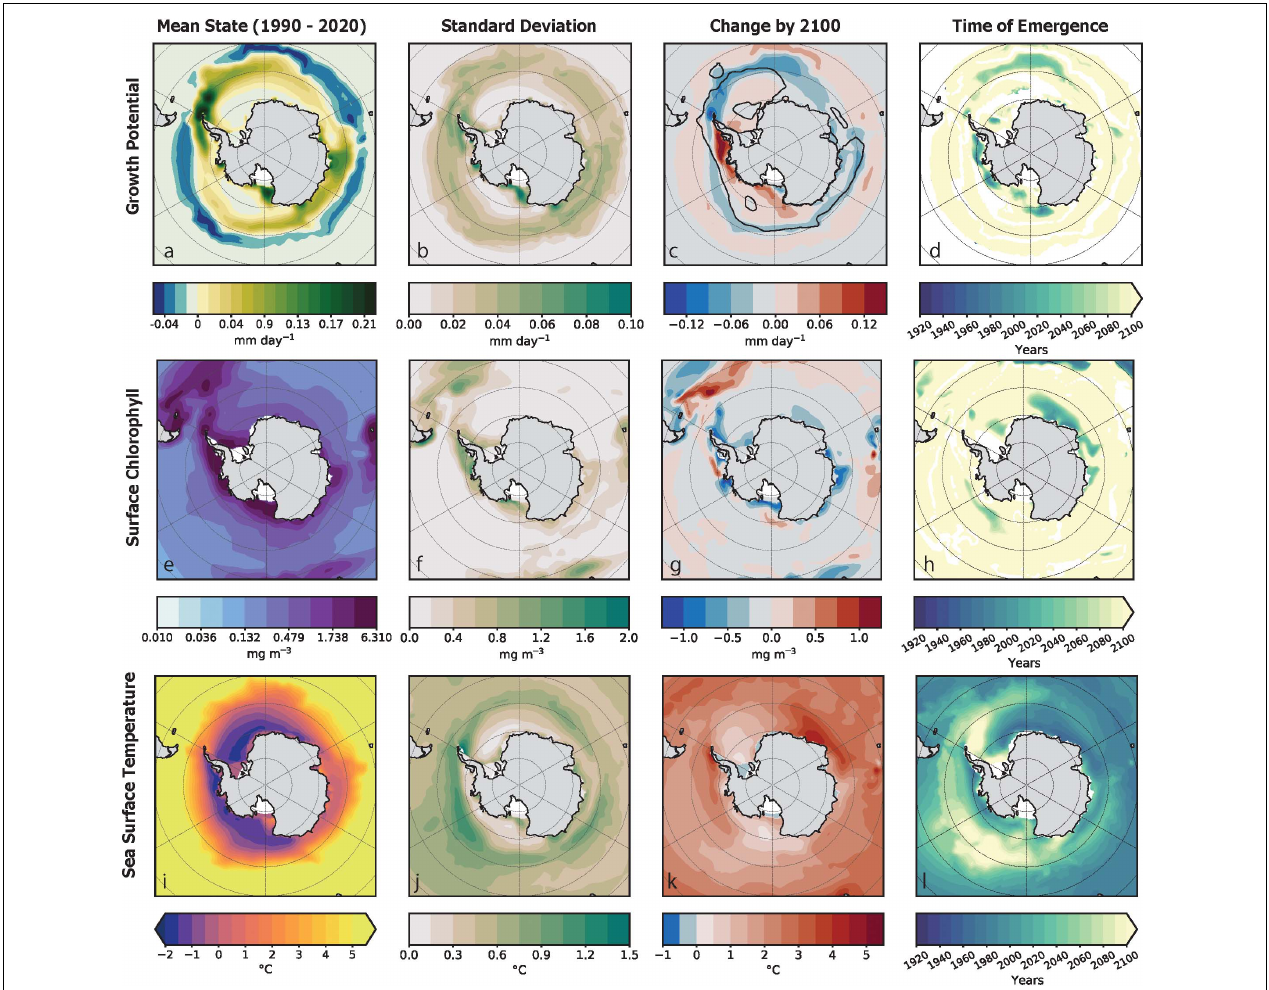
FIGURE 3 | This figure captures the spatial characteristics in the mean state of krill growth potential [top row: (a–d) ], chlorophyll [middle row: (e–h) ] and sea surface temperature [bottom row: (i–l)] as simulated by the large ensemble for the austral summer period. The mean state for the current climate (1990–2020) of the is shown for each variable in the leftmost column. Plot (a) shows growth potential of krill habitat as the rate growth per day (mm day − 1 ) where habitat that can support krill growth is green and habitat where krill growth is inhibited is blue. The mean state of surface chlorophyll concentration (mg m − 3 ), as shown in plot (e) , is plotted on a logarithmic scale. Plot (i) illustrates sea surface temperatures (SST) within the optimal temperature range that the empirical growth model was developed (Atkinson et al., 2006). The second column of plots to the left (b,f,j) shows the standard deviation of the mean state. The column second to the right (c,g,k) is the projected change in the forced signal from the unperturbed climate to the future climate. The difference is shown using a diverging color scale: increasing trends are shown in red and decreasing trends are shown in blue. In plot (c) , a black contour line indicates the distribution of habitat with positive krill GP by 2100. The right most column (d,h,l) is the year of detection of the “time of emergence” of the forced trend for. Areas in white indicate habitat where a ToE could not be detected. Where the ToE could be detected, the earlier the year of the ToE the darker the color represented on the